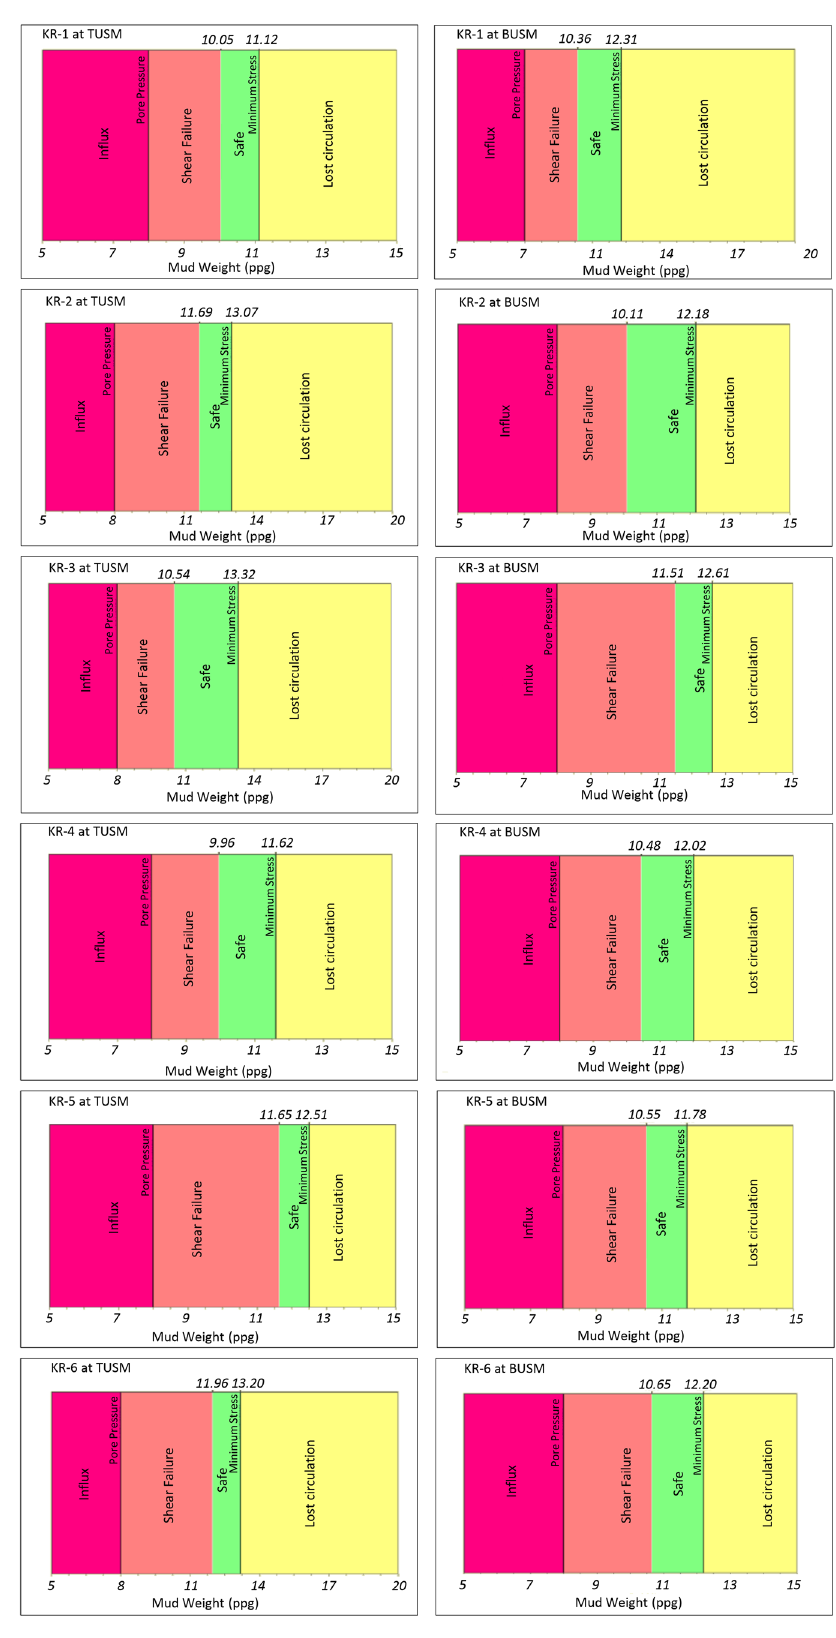
Fig. 8 Safe mud windows for TUSM and